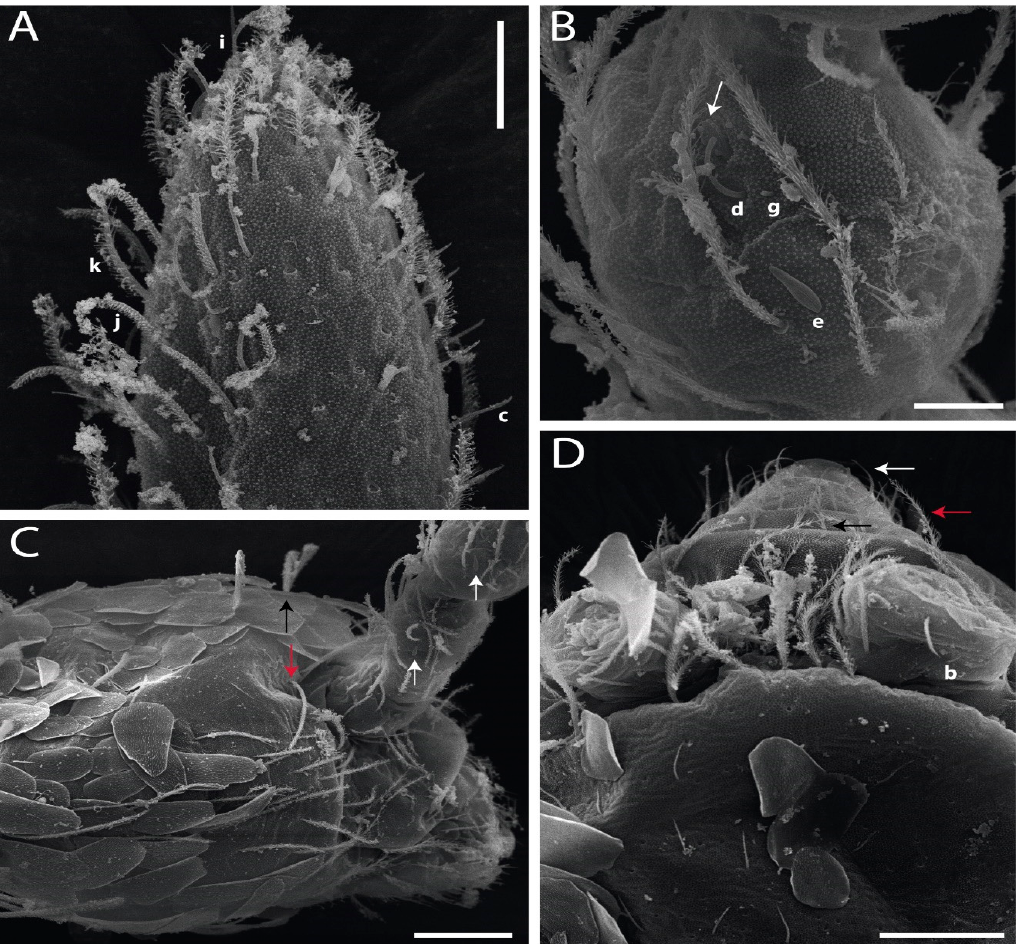
Figure 3. Pseudosinella spp.: SEM of head parts. ( A ) Ant IV distal part (dorsal view); ( c , i – k ) are chaetae types; ( B ) Ant III (lateral view); arrow indicates apical organ, ( d , e , g ) are sens types; ( C ) head and Ant I–III (lateral view); white arrows show sens e on Ant II and III, black arrow indicates mac apically foot-shaped, and red arrow is mac apically acuminate; ( D ) chaetotaxy of clypeus (including prelabral area), labrum, and head anteriorly (dorsal view); b type sens on Ant I: white arrow indicates labral chaetae, black arrow is prelabral chaetae, and red arrow indicates l2 clypeal chaeta. Scale bars: 0.01 mm ( A ), 0.005 mm ( B ), and 0.02 mm ( C – D ).